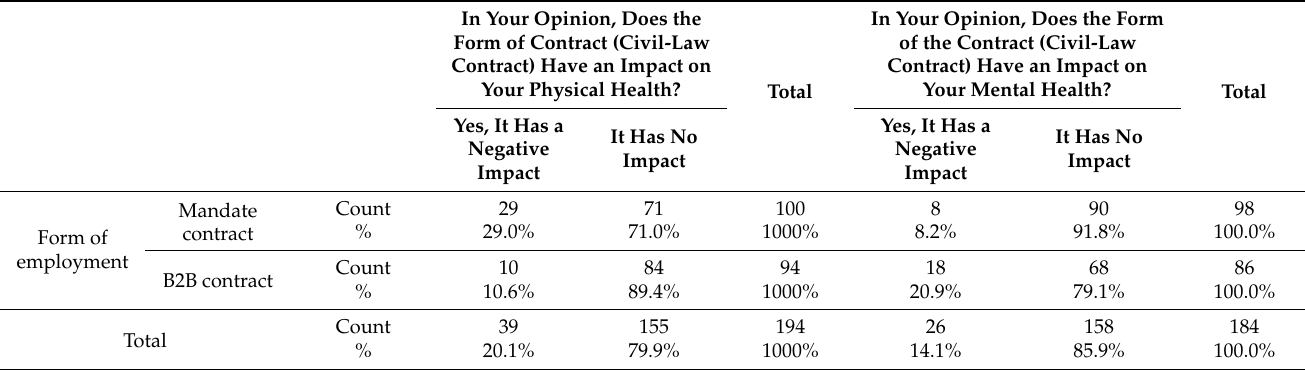
Table 3. The frequency of responses regarding the impact of the form of employment on workers’ physical and mental health. In Your Opinion, Does the Form of Contract